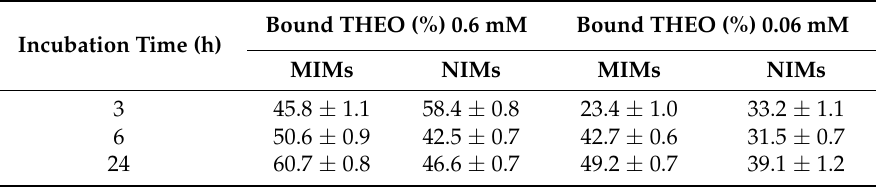
Table 1. Percentages of bound theophylline (THEO) by imprinted (MIMs) and non-imprinted (NIMs) microrods. Data are shown as means ± S.D.